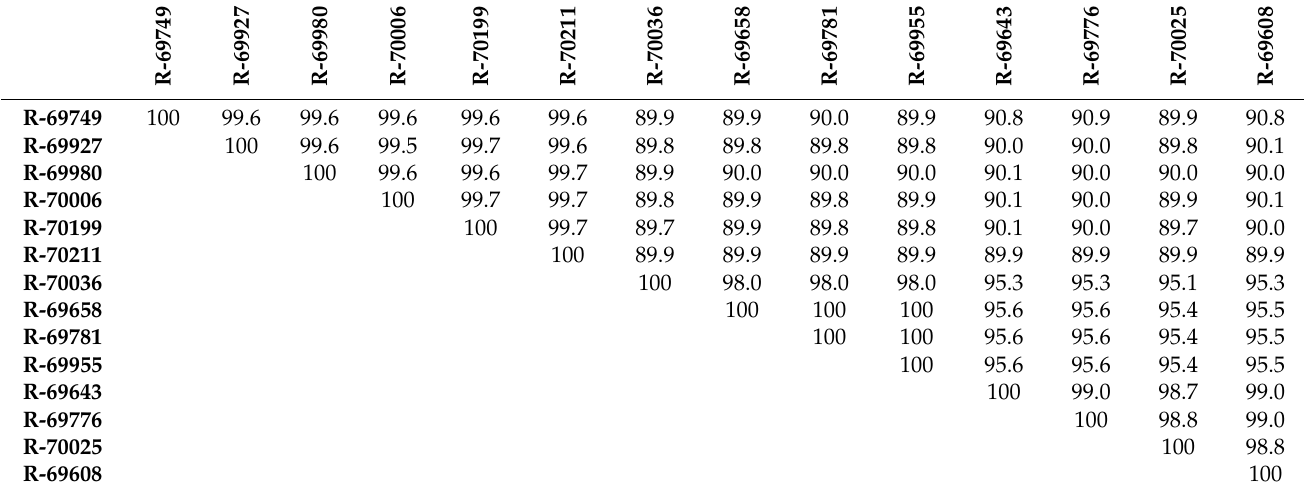
Table 1. Average nucleotide identity values between the soil